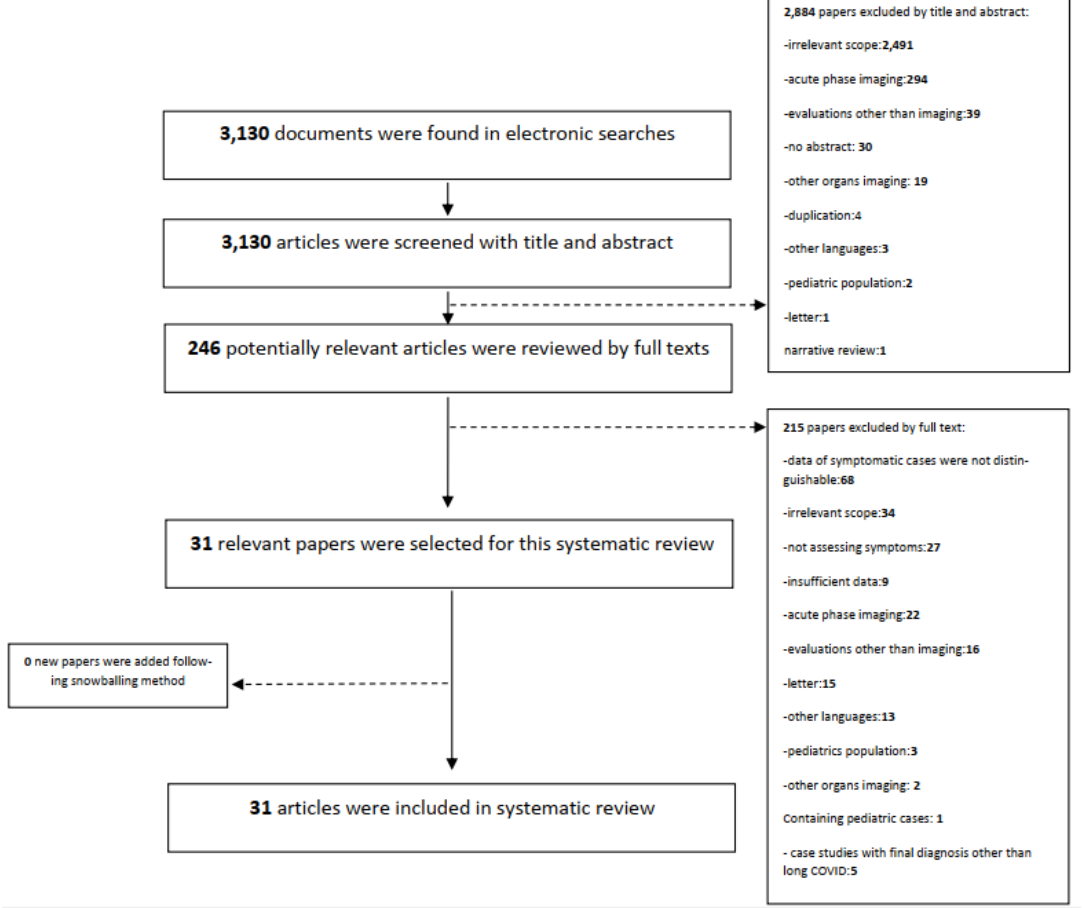
Figure 1. Flowchart of database search and article inclusion.